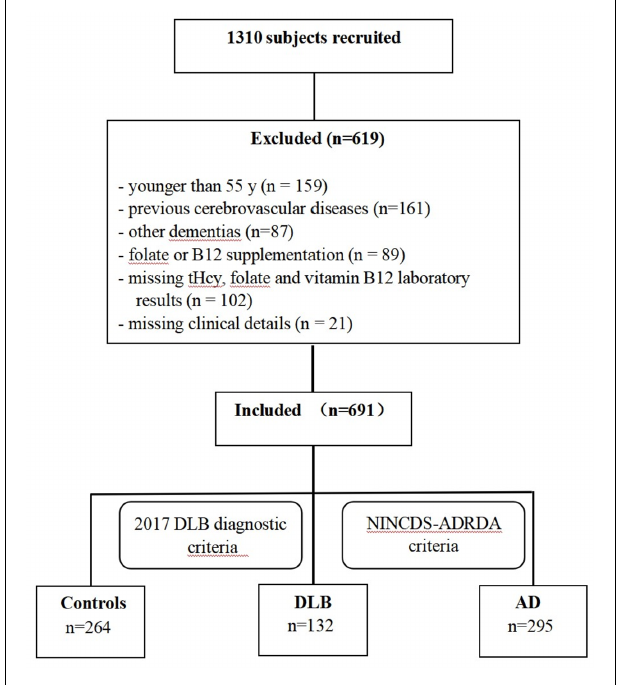
FIGURE 1 | Flowchart of study subjects